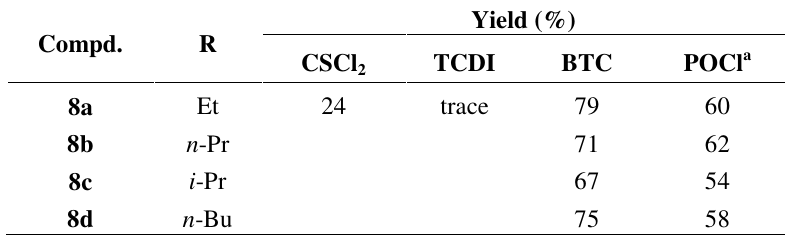
Table 1. Comparison of the yield for intermediates 8a-d using different